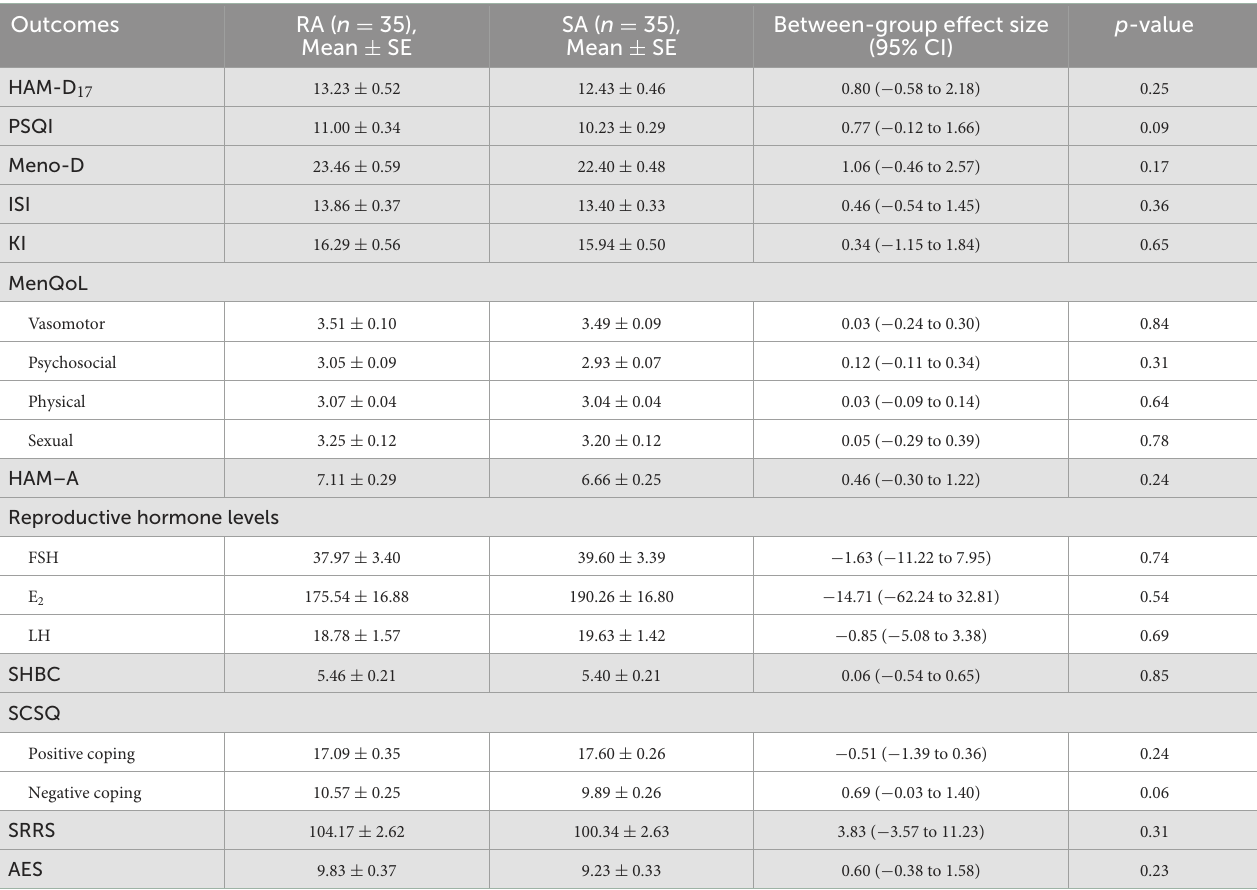
TABLE 2 Clinical characteristics of participants at baseline (participants =